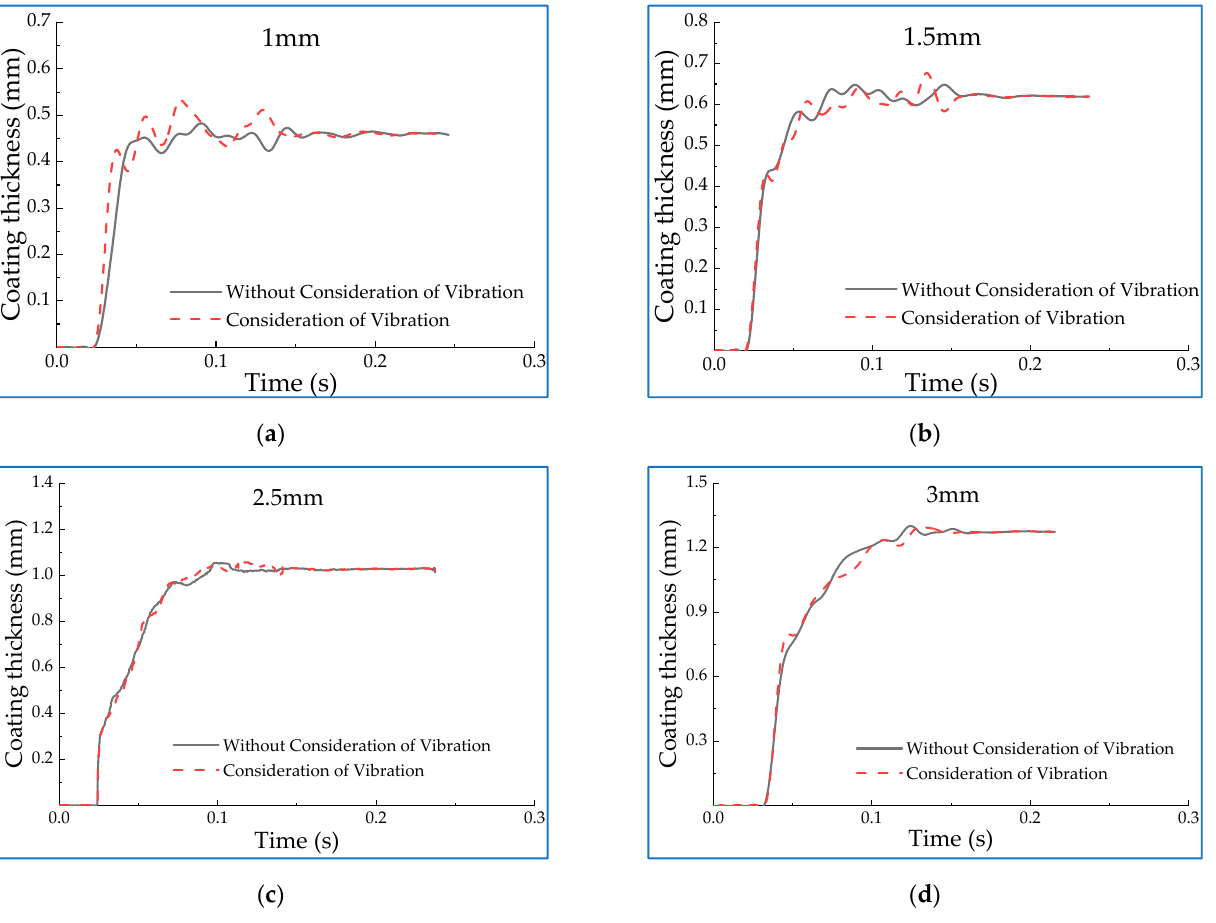
Figure 10. Variation chart of coating thickness under different distances between rollers. The distances are ( a ) 1 mm; ( b ) 1.5 mm; ( c ) 2.5 mm; and ( d ) 3 mm.